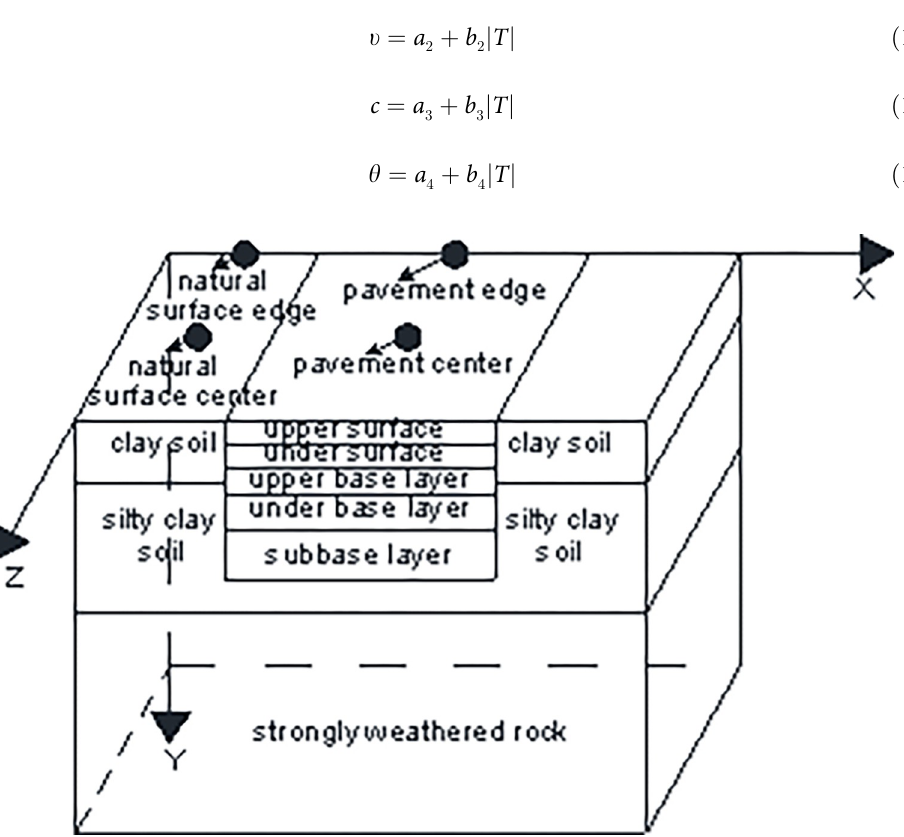
Fig 2. Schematic diagram of numerical